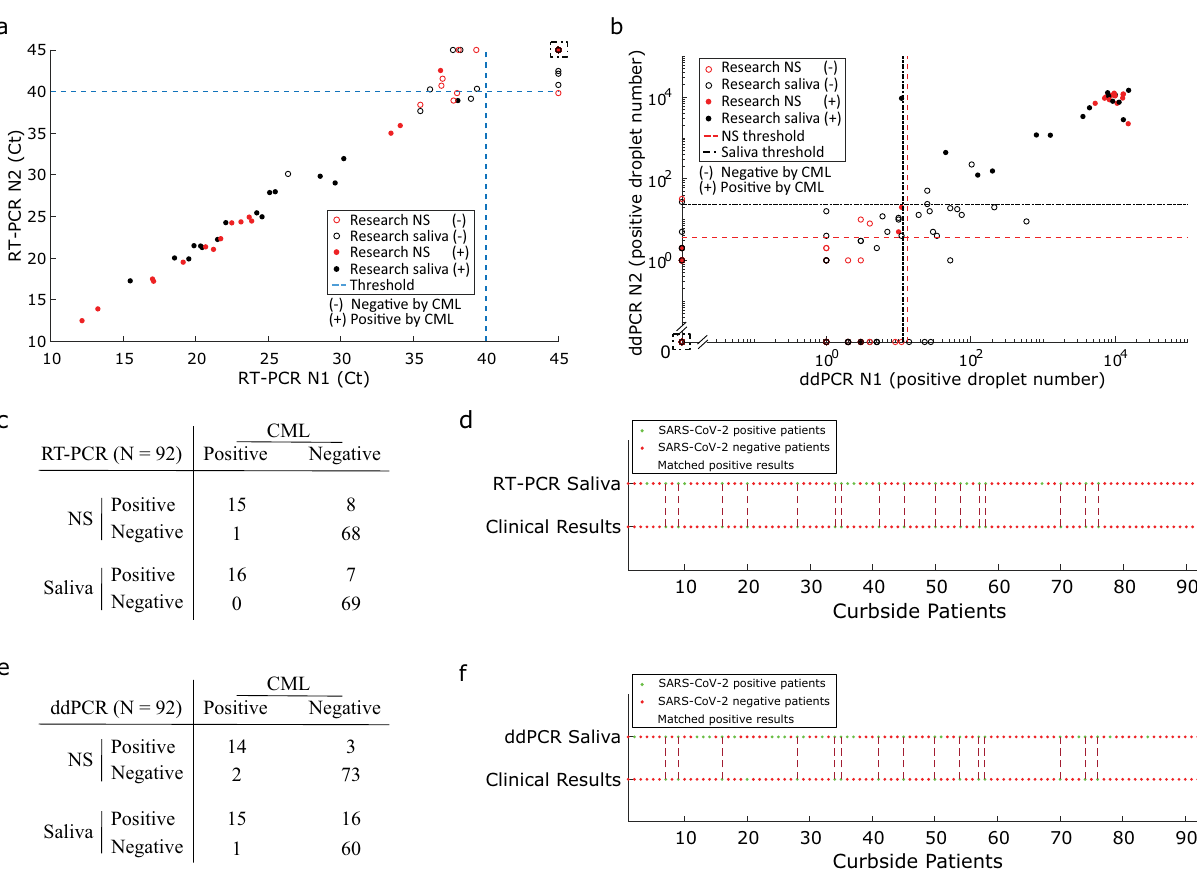
and clinical nasal swab testing in determining positive cases. The clinical microbiology laboratory detected 16 positive patients out of 92 samples collected at the curbside facility. Out of 16 clinically positive patients, 16 (100%) and 15 (93.75%) were detected as positive by our saliva-based RT-PCR and ddPCR readout, respectively.